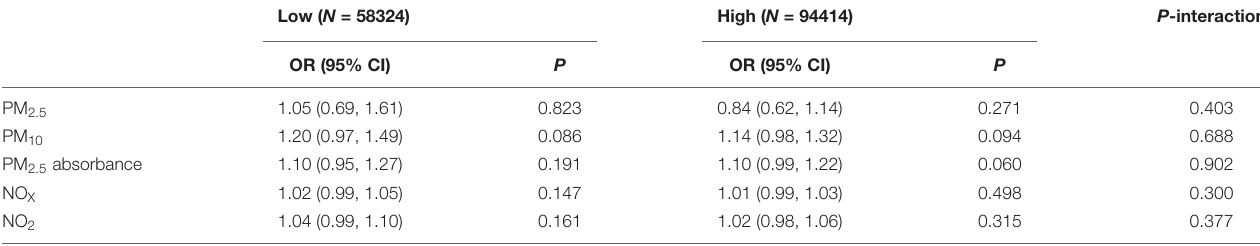
TABLE 3 | Associations of air pollution and hearing impairment in subgroups stratified by healthy diet scores. Low ( N = 58324) High ( N = 94414)